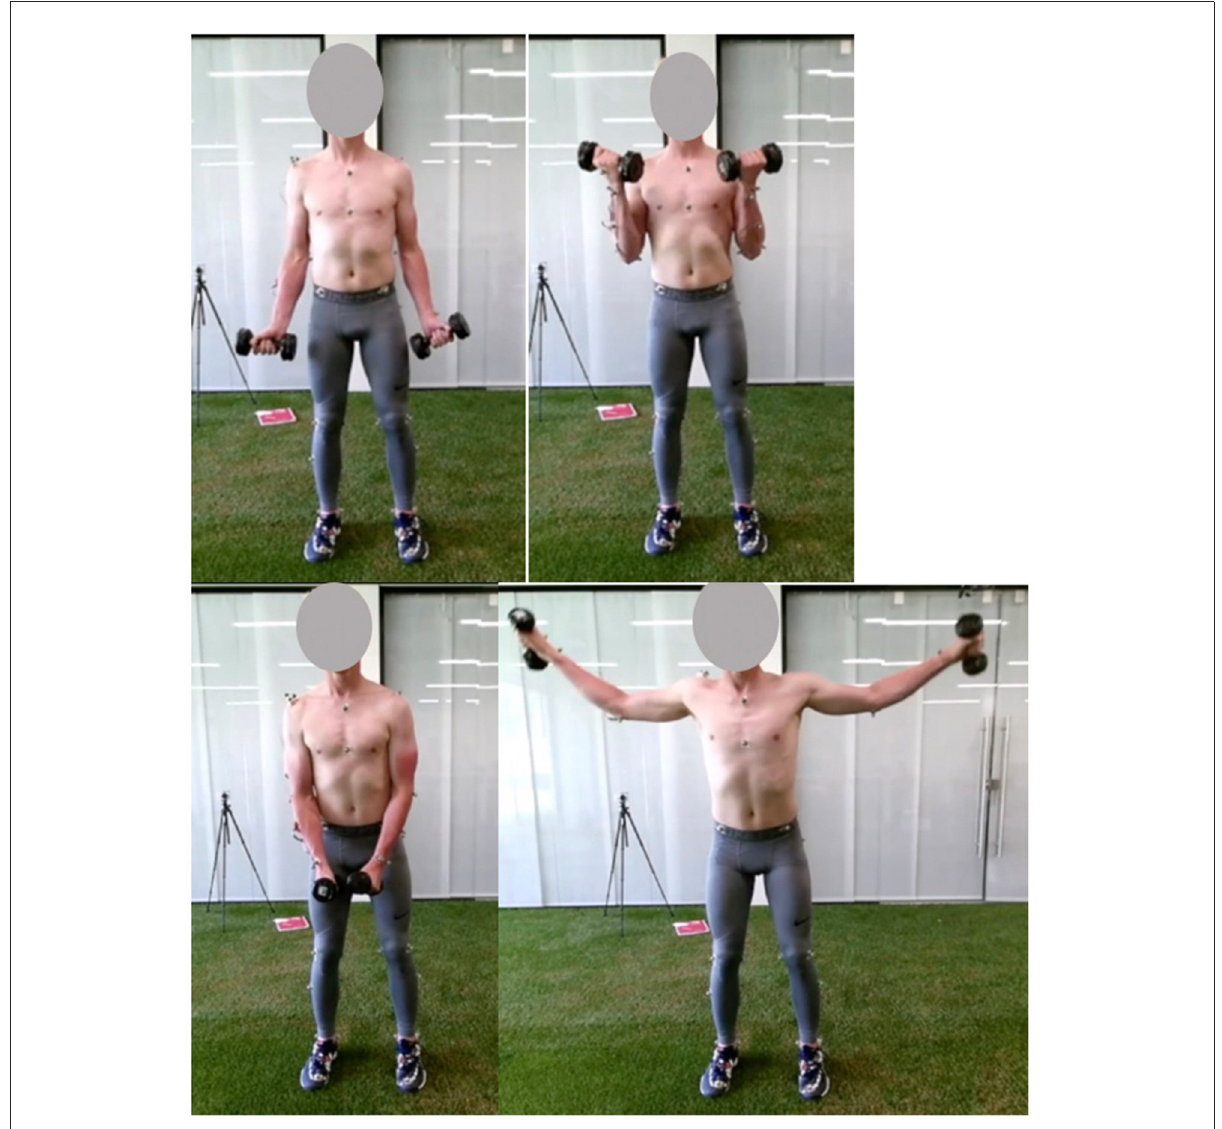
FIGURE1 Pictures of the start (left) and mid (right) pose of the biceps curl (top) and lateral fly (bottom)